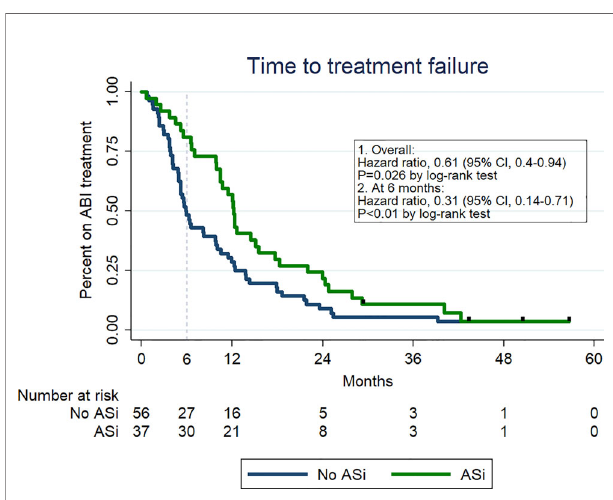
FIGURE 1 | Kaplan-Meier curves of time to treatment failure depending on the ASi therapy.